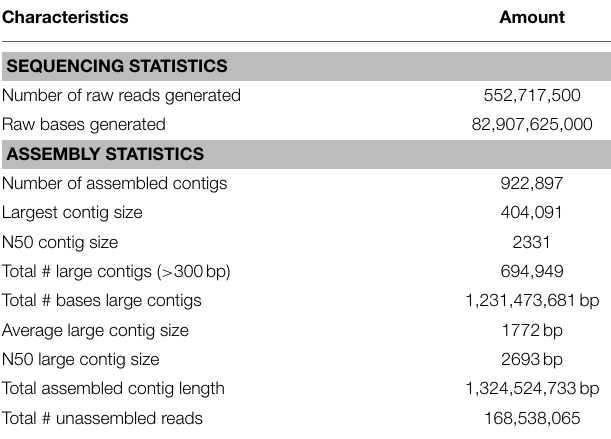
TABLE 1 | HiSeq sequencing